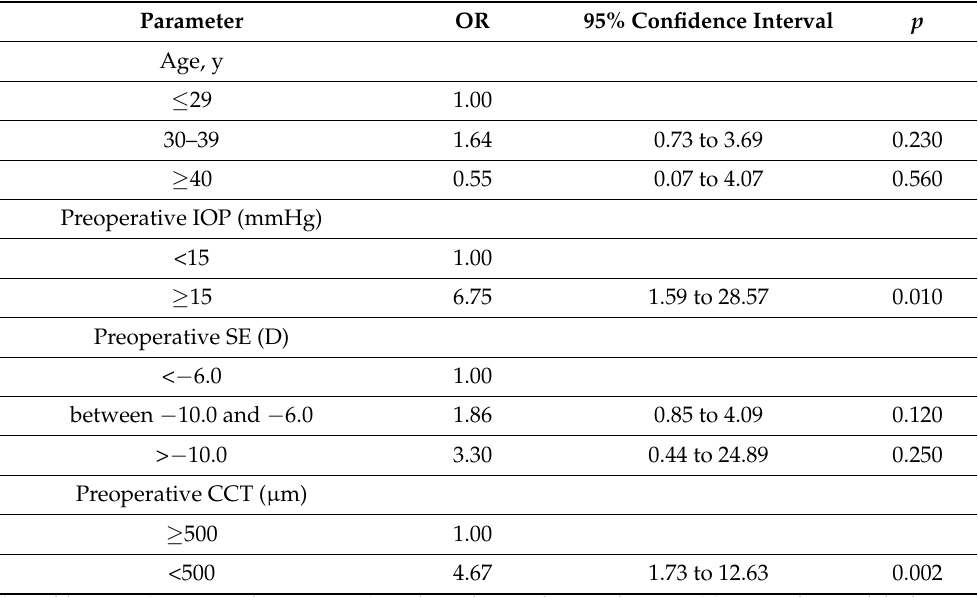
Table 6. Univariate logistic regression analysis to assess the predictor variables of postoperative corneal opacity.